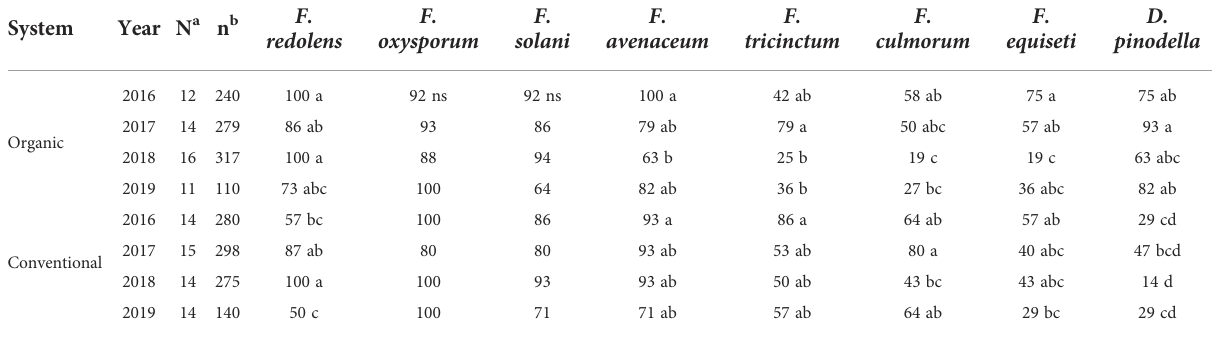
TABLE 4 Variation in isolation frequencies (%) of the eight most common fungal species recovered from faba bean roots separated based on sampling year and management system. System